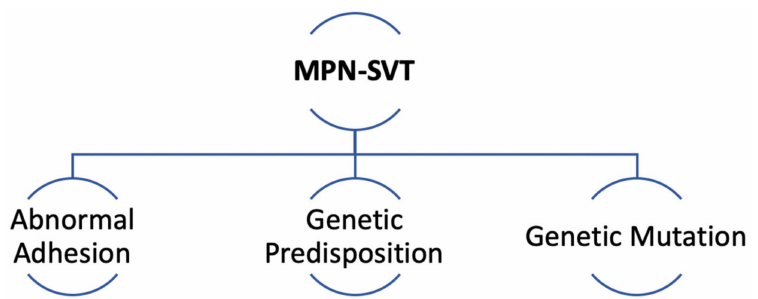
Figure 1. The Pathogenesis of Myeloproliferative Neoplasm-associated Splanchnic Vein Thrombosis (MPN-SVT). MPNs lead to the formation of thrombi through a number of mechanisms. Endothelial cells have been known to harbor JAK2, leading to abnormal adhesion. Patients with a JAK2 46/1 haplotype are more susceptible to MPN-SVT [18]. The genetic mutations that promote thrombosis in MPN include JAK2 V617F most frequently, but can also include CALR and MPL. Increased red cell mass in MPNs, particularly PV, can increase nitric oxide scavenging by erythrocyte hemoglobin in low-flow areas such as the splanchnic vasculature